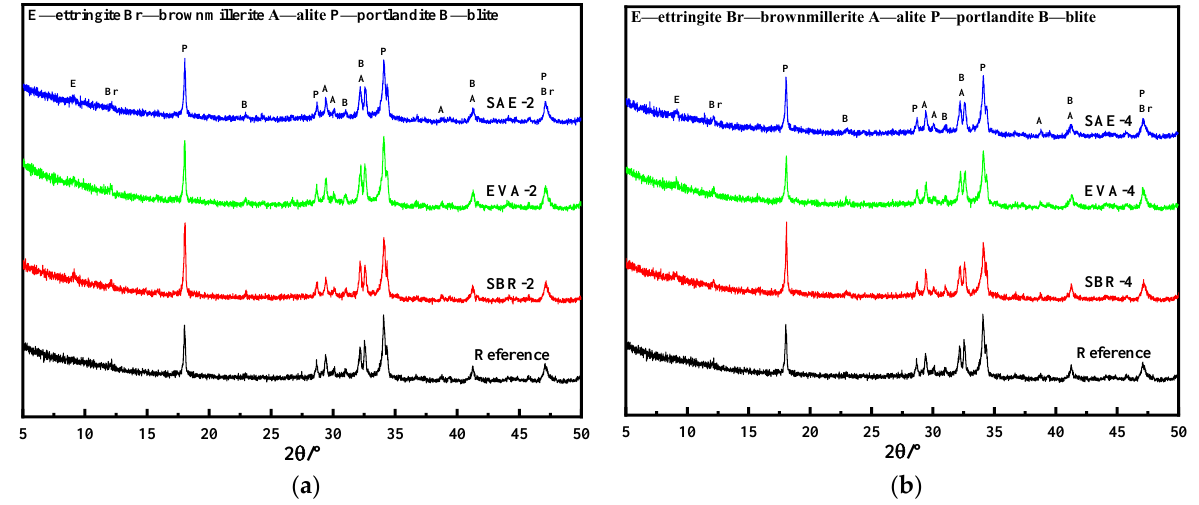
Figure 5. XRD patterns of paste samples with different types and contents of polymer latex at 28 days: ( a ) polymer–cement ratio is 6%; ( b ) polymer–cement ratio is 12%.